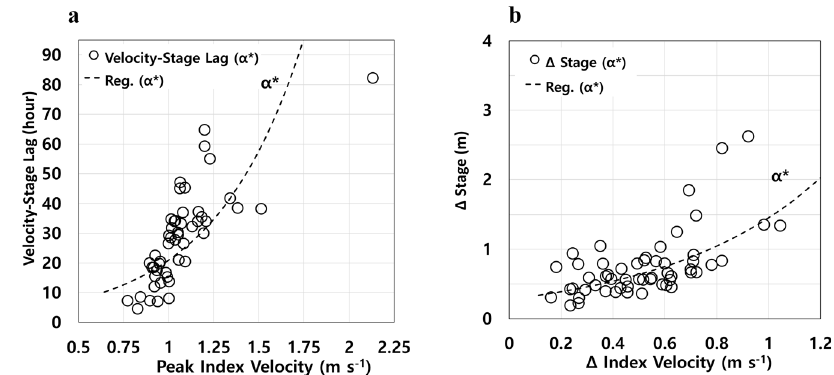
Fig. 2 Parameterized velocity-stage peak correlations. a Index-velocity vs. stage peak lag and b index-velocity gradient vs. associated stage peak gradient. Note: the unsteadiness coef fi cient, α *, is determined with Eq. (4) applied to the 2014 – 2018 training dataset (see the “ Methods ” section and Supplementary Data 3). Table 2 Forecasting protocol performance tested on the largest annual storms during 2014 – 2019 period.